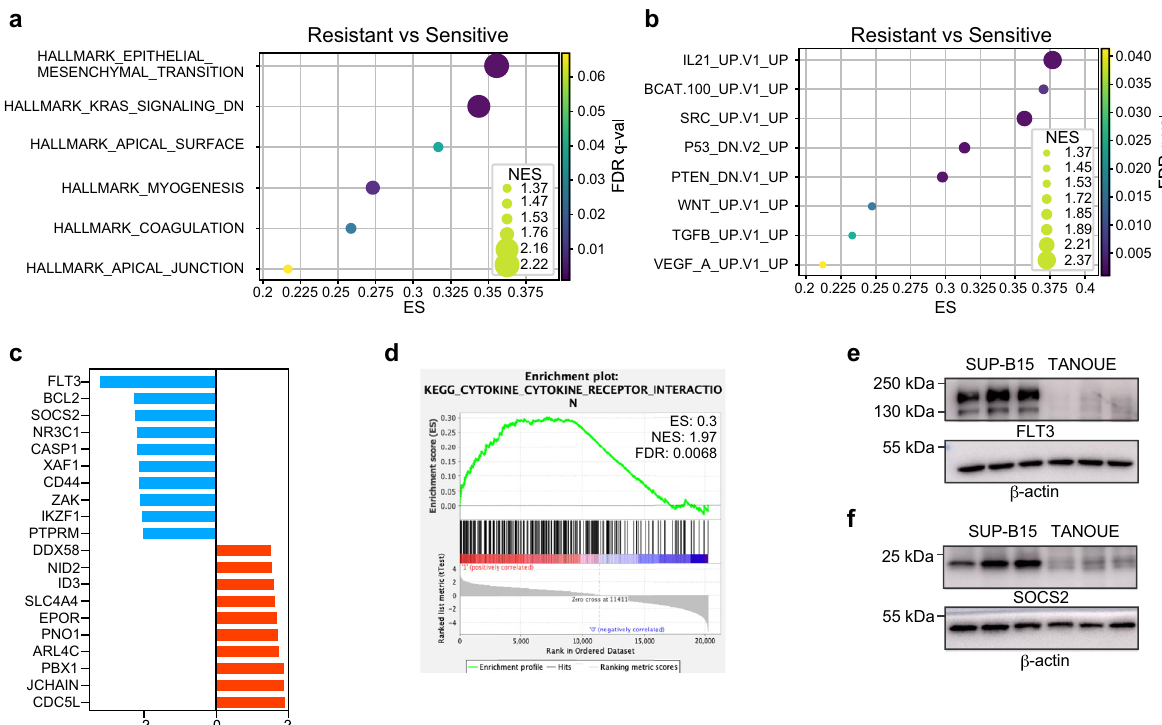
Fig. 5 Pathway enrichment in dexamethasone-resistant ALL patient samples. Pathway enrichment in dexamethasone-resistant ALL patient samples was analyzed using GSEA. a Hallmarks and b Oncogenic signatures gene sets were used for pathway enrichment analysis. c Upregulated and downregulated genes in dexamethasone-resistant ALL patient samples were determined by SAM. The bar graph shows selected top-listed genes. All the upregulated and downregulated genes are included in supplementary table T2. d The enrichment of KEGG cytokine and cytokine receptor interaction pathway in dexamethasone-resistant ALL patient samples was determined by GSEA. e , f SUP-B15 and TANOUE cells were lysed. Lysates were analyzed by SDS-PAGE and western blotting using speci fi c antibodies as labeled. Blots shown in each panel were from the same experiment and processed